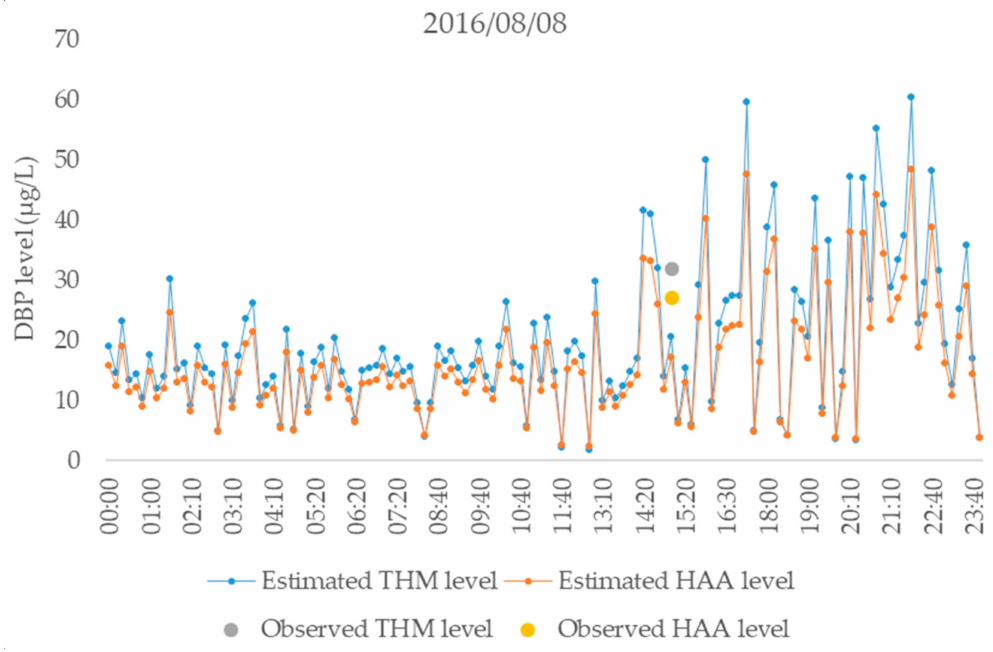
Figure 6. Evolution of real-time estimated THM and HAA levels at TW throughout one